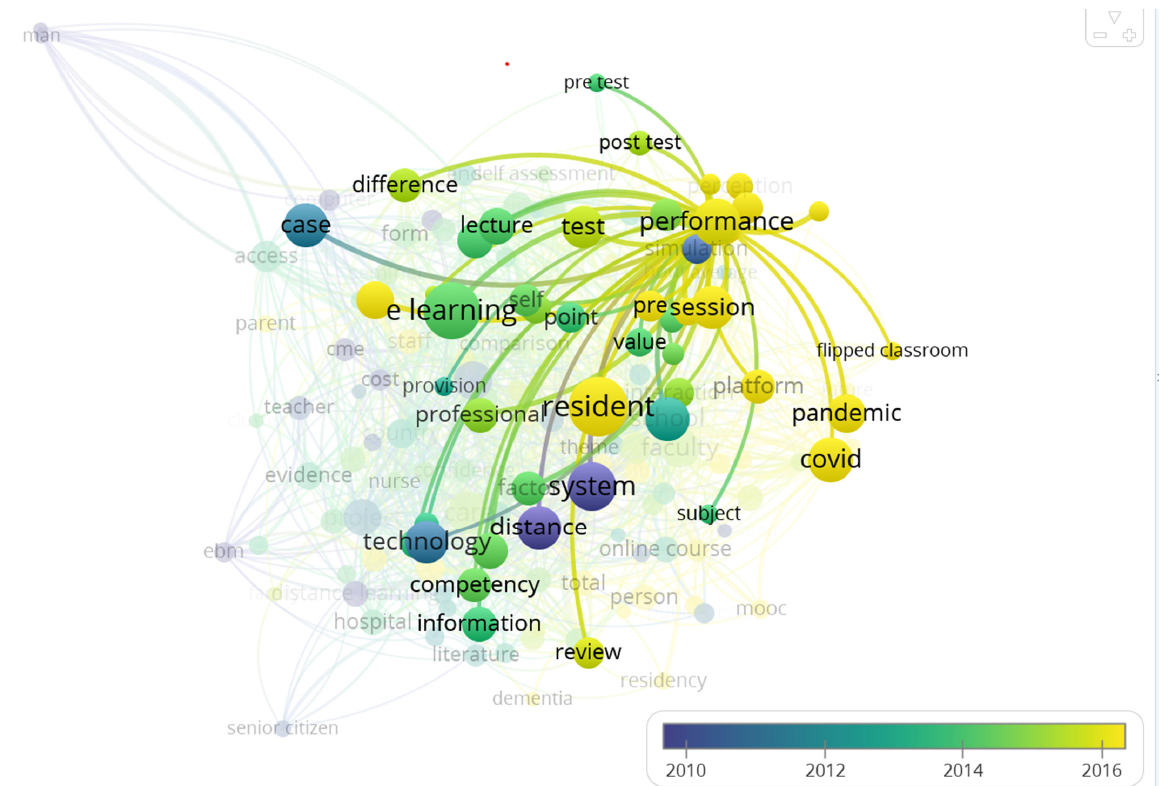
Figure 11. Terms co-occurring with performance.